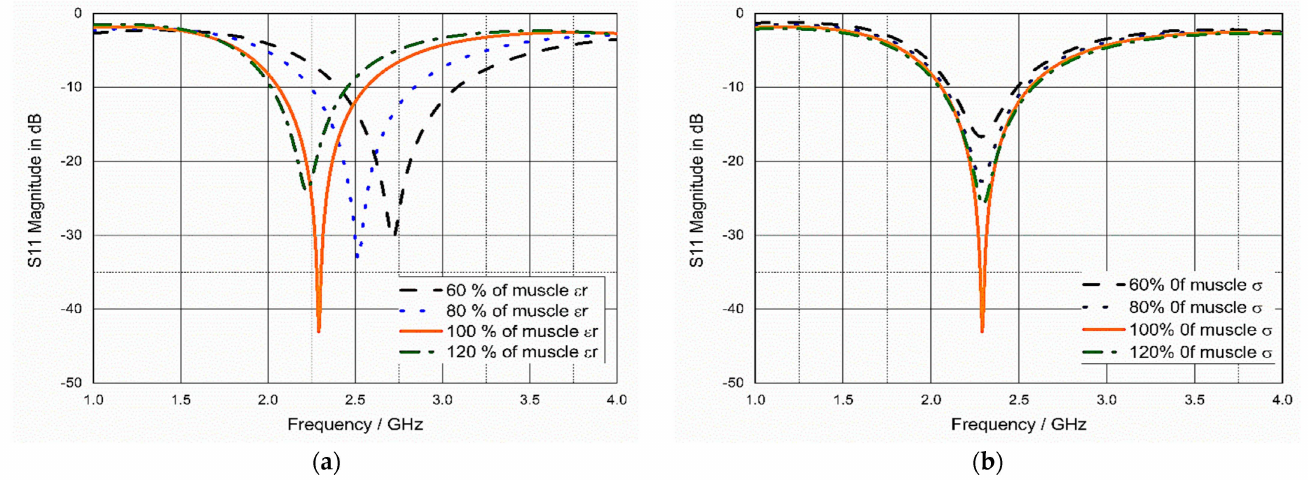
Figure 6. Sensitivity analysis: ( a ) S 11 in terms of relative permittivity of muscle, ε r , which changed from 60% to 120% from its values at 2.45 GHz, and ( b ) S 11 in terms of conductivity of muscle, σ , which changed from 60% to 120% from its values at 2.45